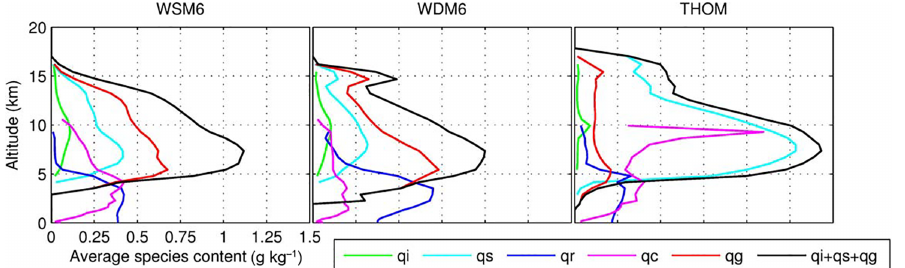
Figure 5. The domain-averaged vertical species content as modelled by WRF between 18:00 and 19:00UTC by the WSM6, WDM6 and THOM microphysics options. Units are in gkg − 1 for all species, and the domain average is calculated from Fig.